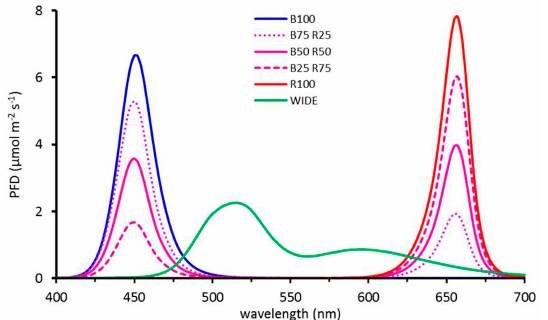
Figure 1. Light spectra in the six experimental light treatments. Photon flux densities (PFD) were recorded by a LI-180 spectrometer (LI-COR inc., Nebraska, NE, USA). Trays were sub-irrigated three times a week during the entire crop cycle to restore the water-holding capacity of the substrate.